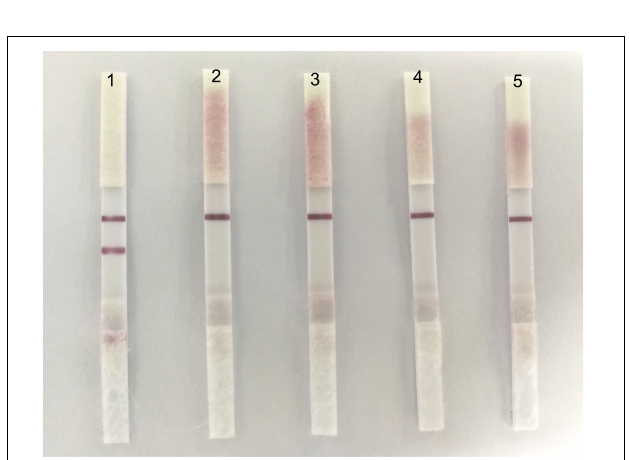
FIGURE 4 | The specificity of the ICS. 1: DTMUV, 2: NDV, 3: DPV, 4: H9N2-AIV, and 5: ARV. ICS only reacted with DTMUV, and there was no cross reaction with NDV, DPV, H9N2-AIV, or ARV.